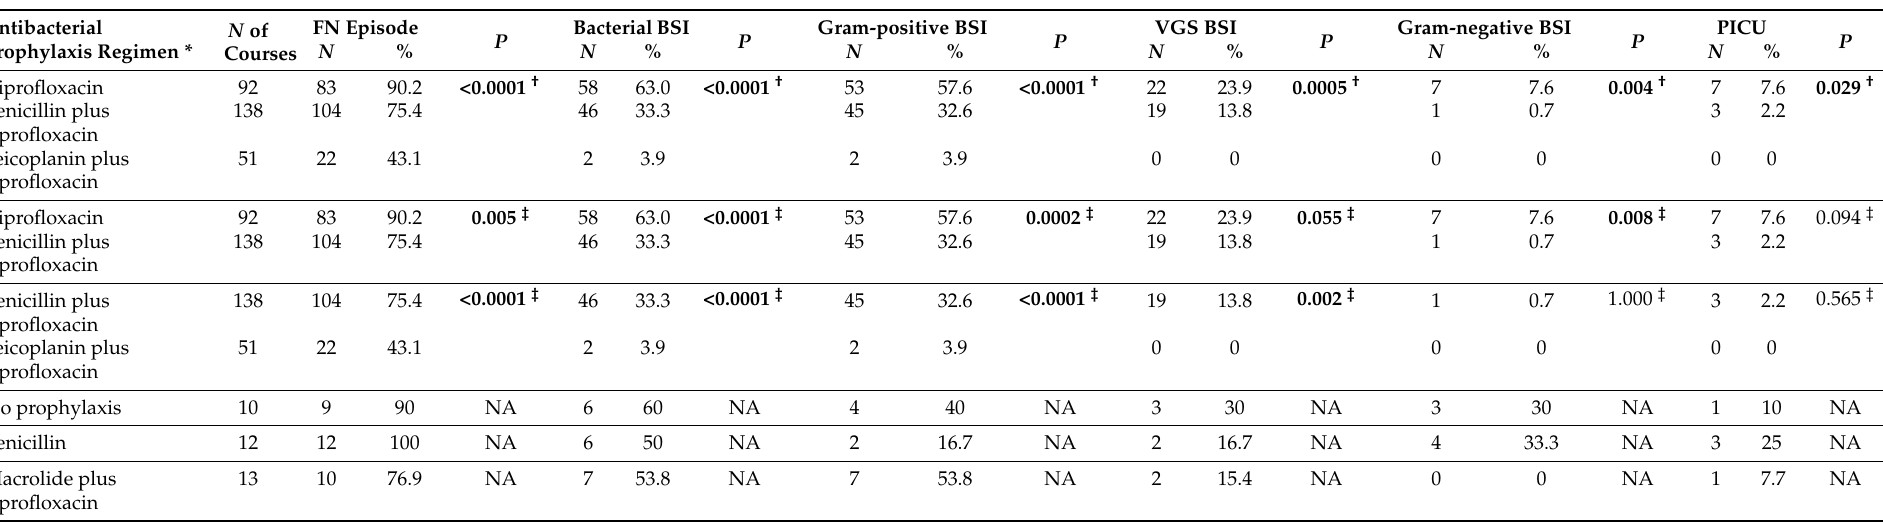
Table 2. The incidence of febrile neutropenic episodes, bacterial bloodstream infections, and bacterial bloodstream infection-related pediatric intensive care unit admissions according to antibacterial prophylaxis regimen in pediatric acute myeloid leukemia